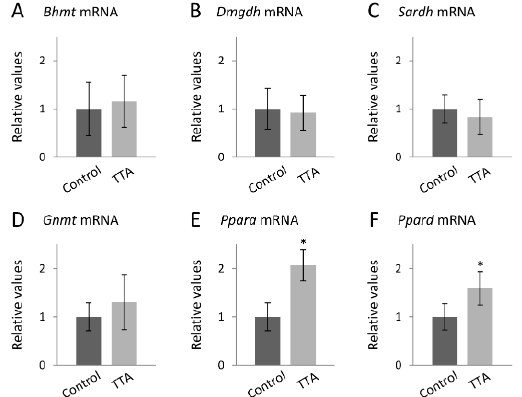
TTA treatment, n = 10 in each group. RNA was purified from frozen liver samples, and gene expression was quantified relative to a reference gene. The bars represent the relative gene expression of Bhmt ( A ); Dmgdh ( B ); Sardh ( C ); Gnmt ( D ); Ppar α ( E ); and Ppard ( F ) compared to the Control group. Group differences are evaluated with t -test and Mann-Whitney U test, and * indicates p < 0.001. Bhmt indicates betaine-homocysteine methyltransferase; Dmgdh, dimethylglycine dehydrogenase; Gnmt, glycine